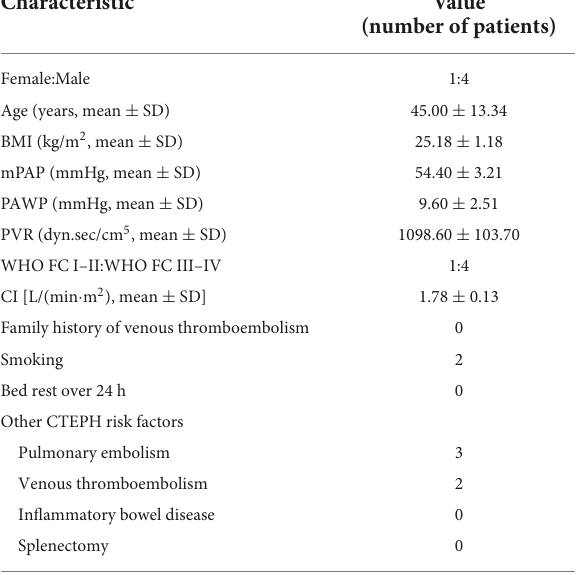
TABLE 1 Baseline characteristics of patients with CTEPH.